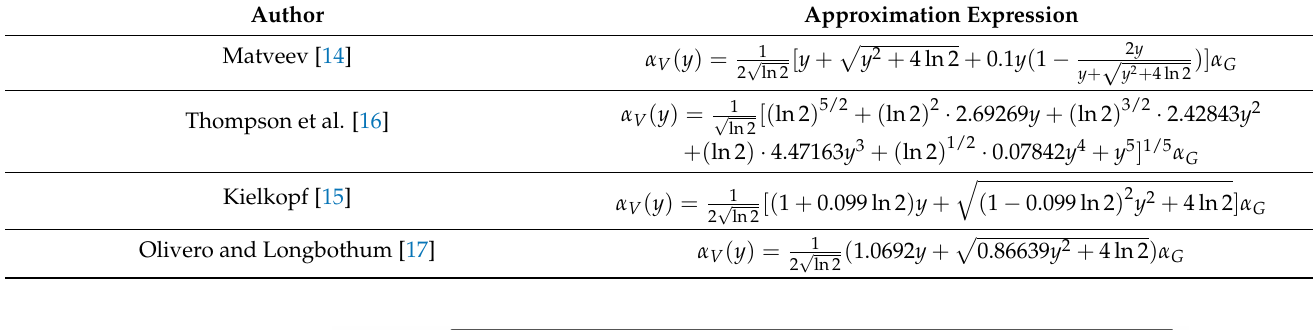
Table 1. Empirical fit to the Voigt half width.